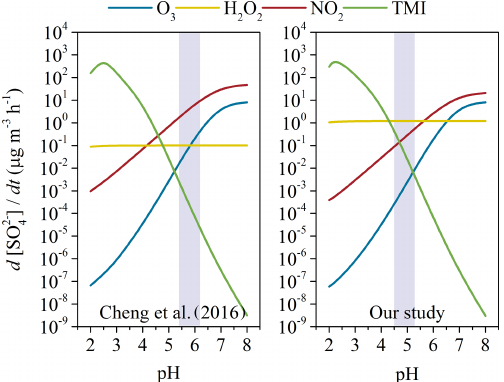
Figure 6. The comparison of aqueous-phase sulfate production by SO 2 oxidation under different aerosol pH conditions between in the study of Cheng et al. (2016) and in this study.